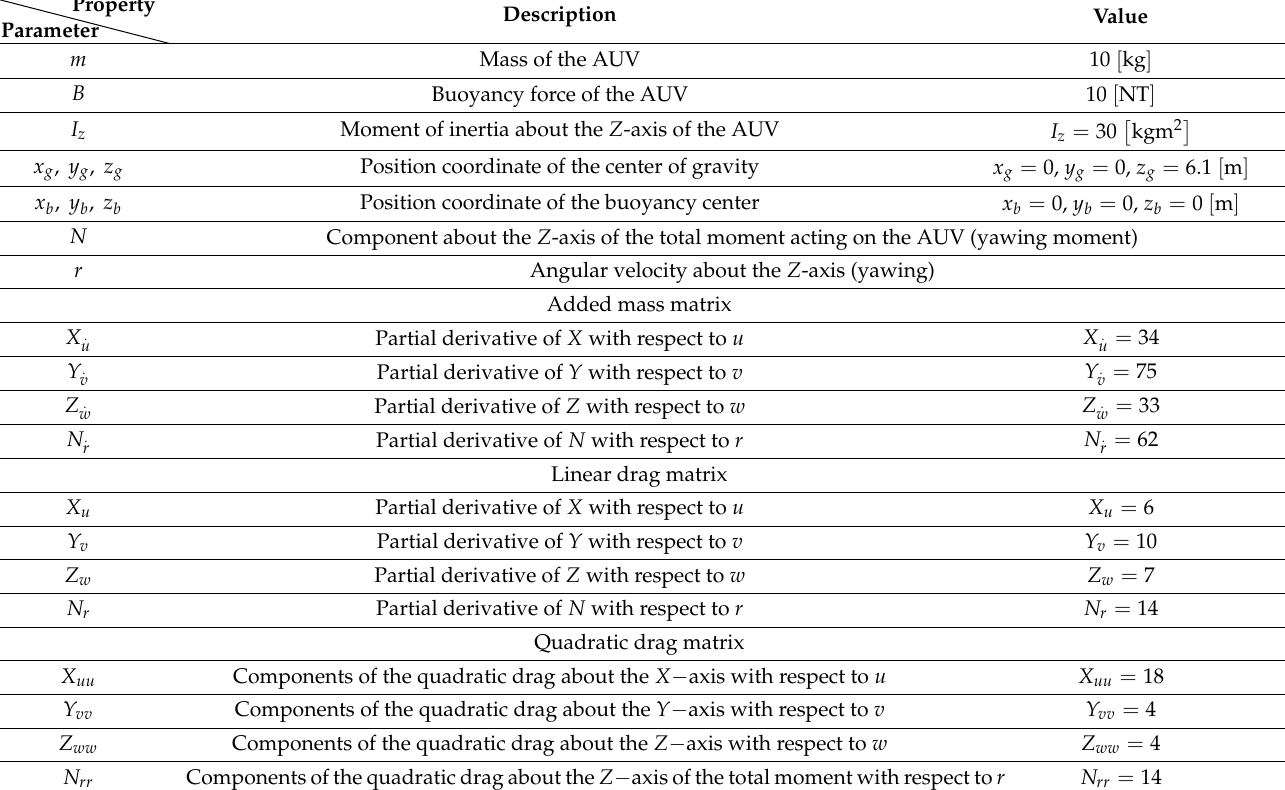
Table 1. Parameters of the AUV